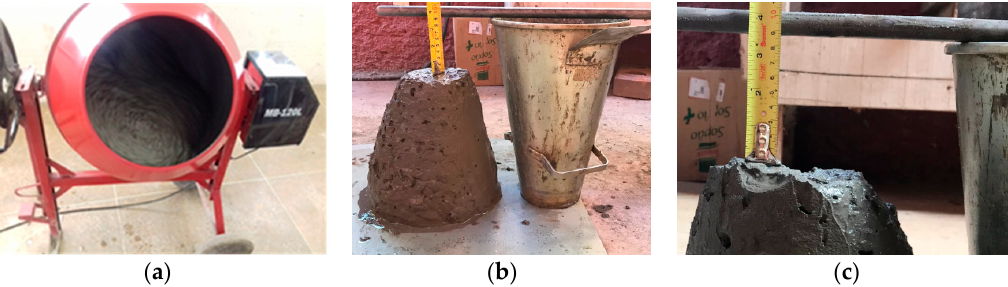
Figure 10. Execution of concrete mixes. ( a ) Inclined-axis electric concrete mixer, ( b ) concrete without fiber, ( c ) concrete with using fiber.